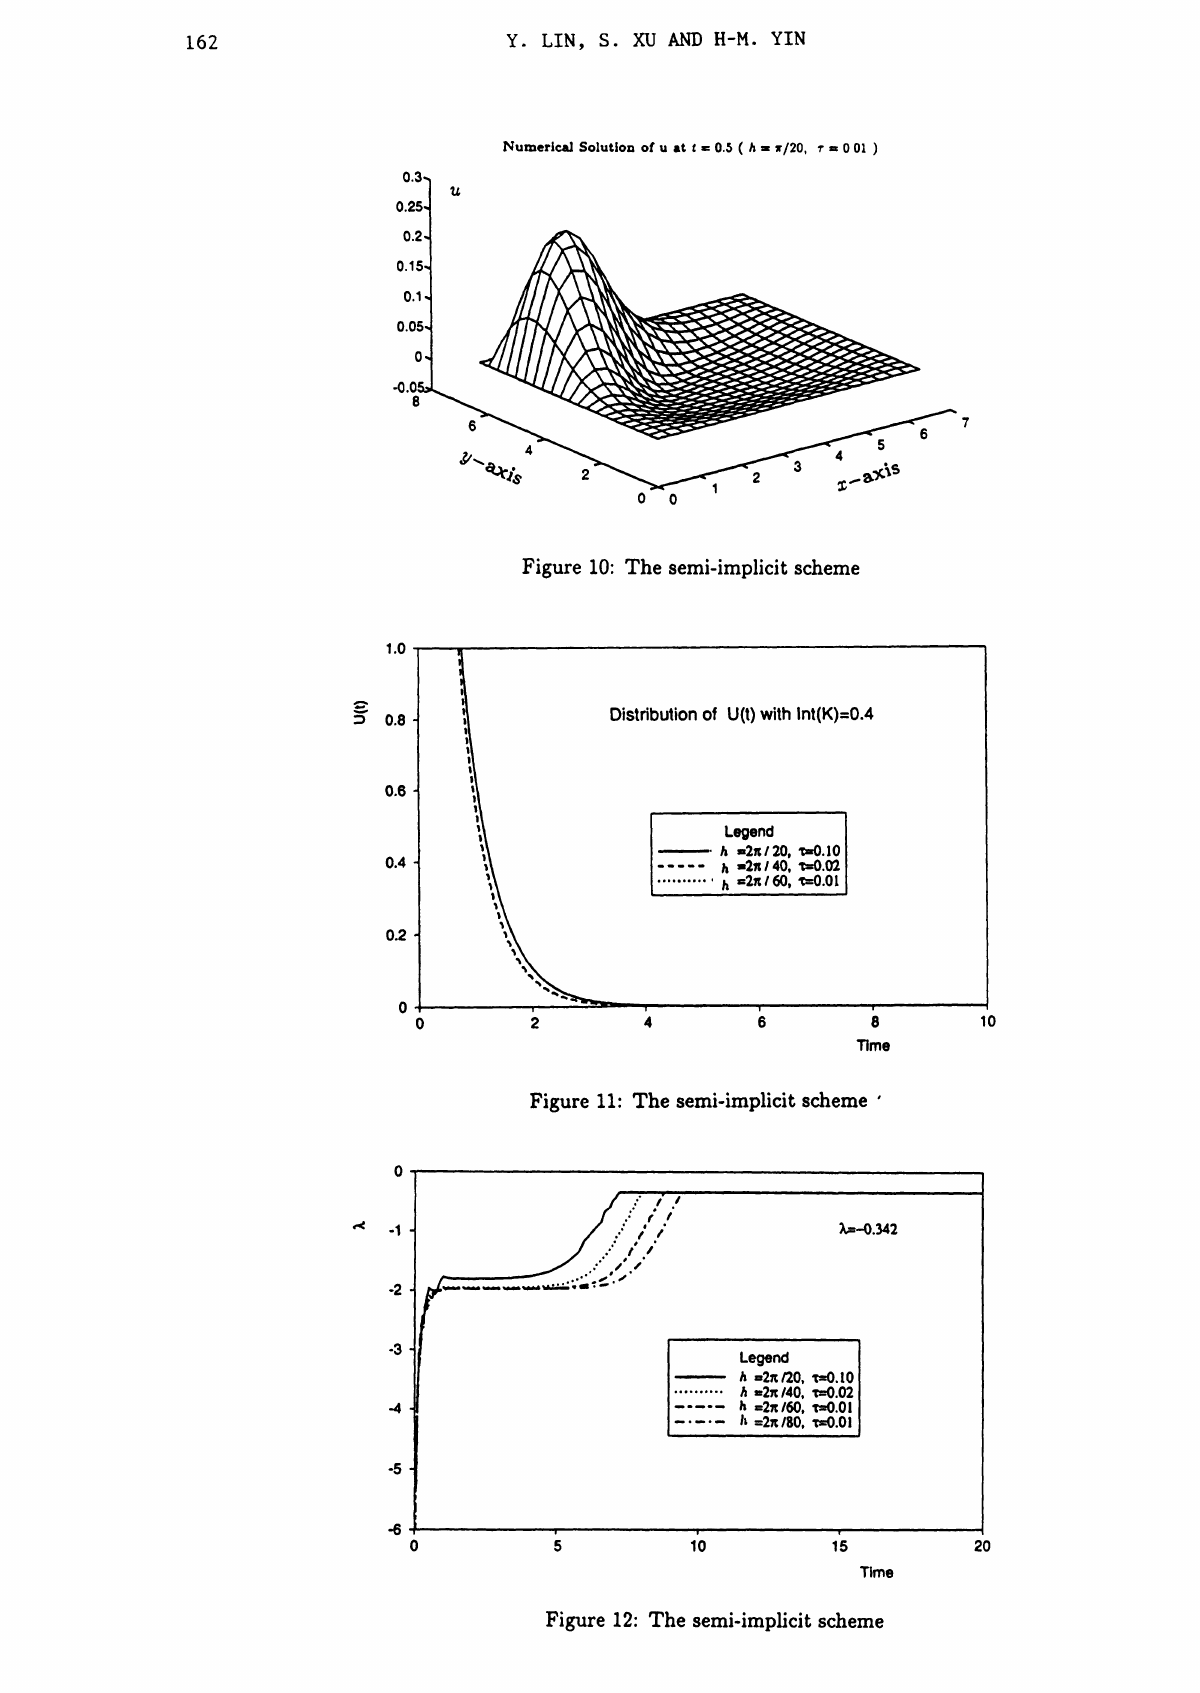
Figure 12: The semi-implicit